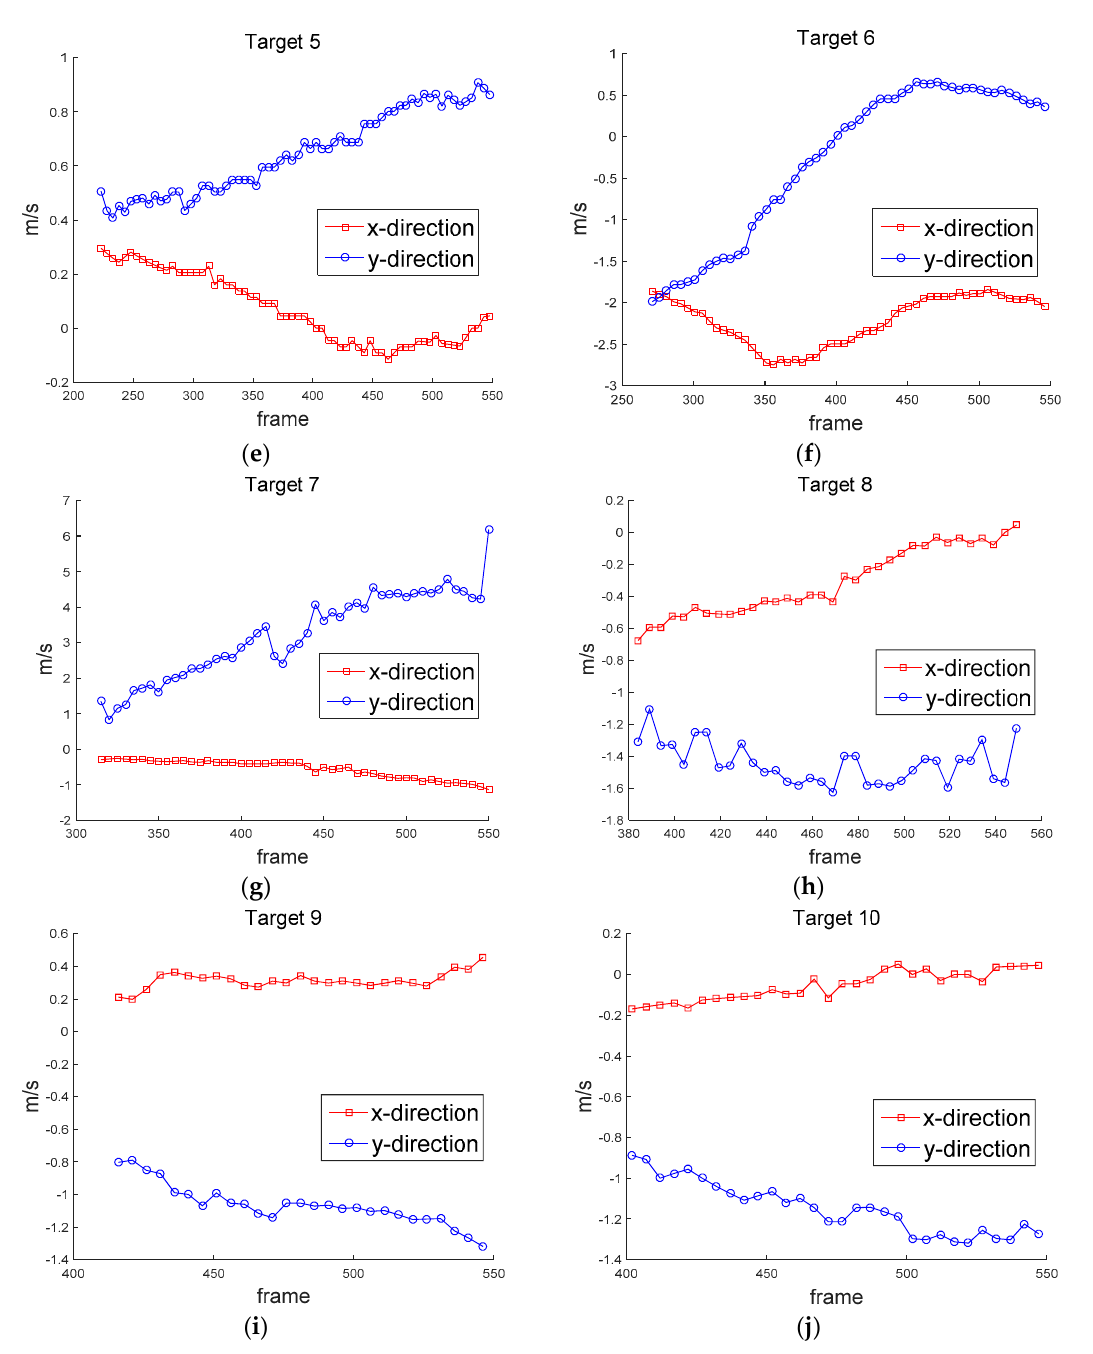
Figure 13. Ground truth of velocity in x and y directions, ( a ) Target 1, ( b ) Target 2, ( c ) Target 3, ( d )